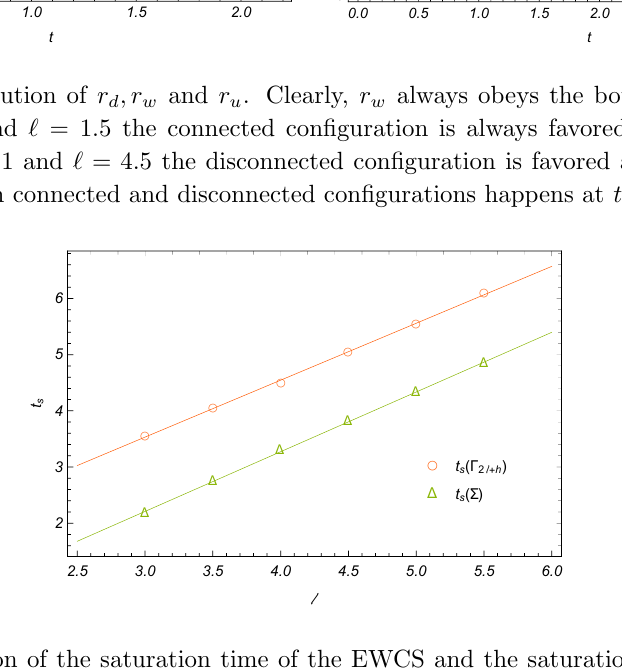
Figure 9 . Comparison of the saturation time of the EWCS and the saturation time of the HEE corresponding to (cid:0) 2 ‘ + h when the disconnected con(cid:12)guration is favored at late times for di(cid:11)erent values of ‘ . Clearly, t s ((cid:0) 2 ‘ + h ) is always greater than t s ((cid:6)). Here we have set h =